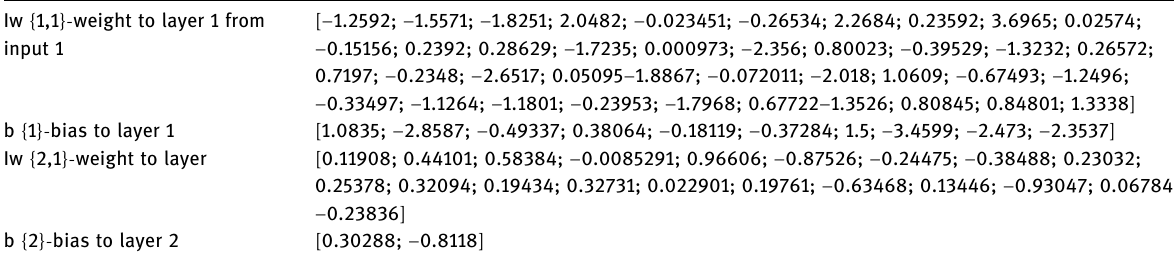
Table 4: Weight and bias values in ANN model Iw { 1,1 }- weight to layer 1